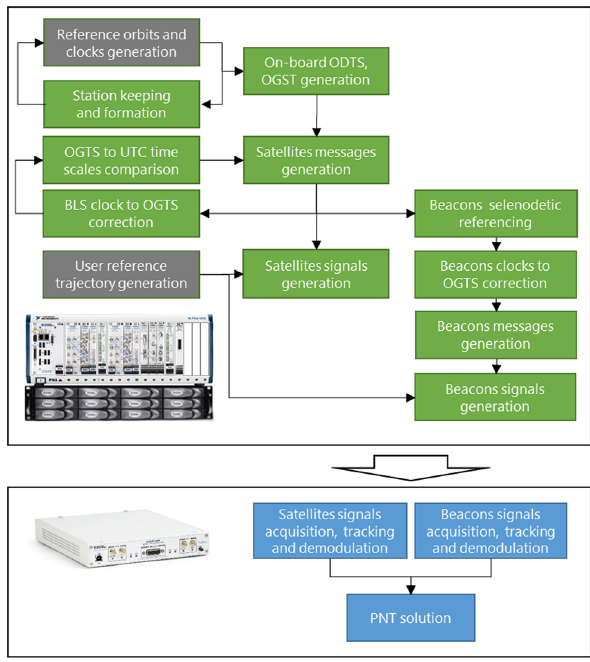
Figure 8: LNSS simulator simpli fi ed